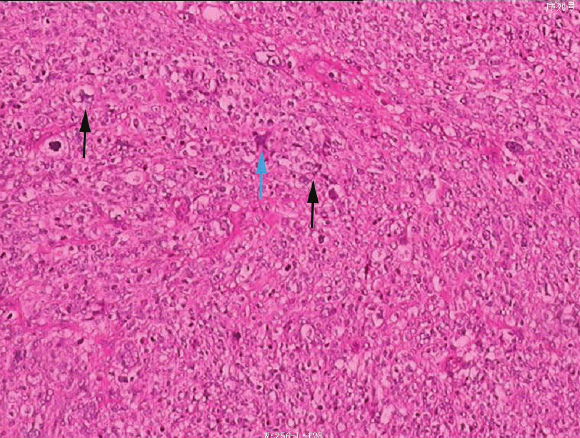
Figure 3: Histopathological slide of the pelvic wall mass of the second surgery. It revealed the lipoblasts and pleomorphic cells. The black arrows indicate lipoblasts, which were characterized by heterotypic, hyperchromatic nuclei with uni/multivacuolated cytoplasm. The blue arrow indicates one of the pleomorphic cells, polymorphonuclear